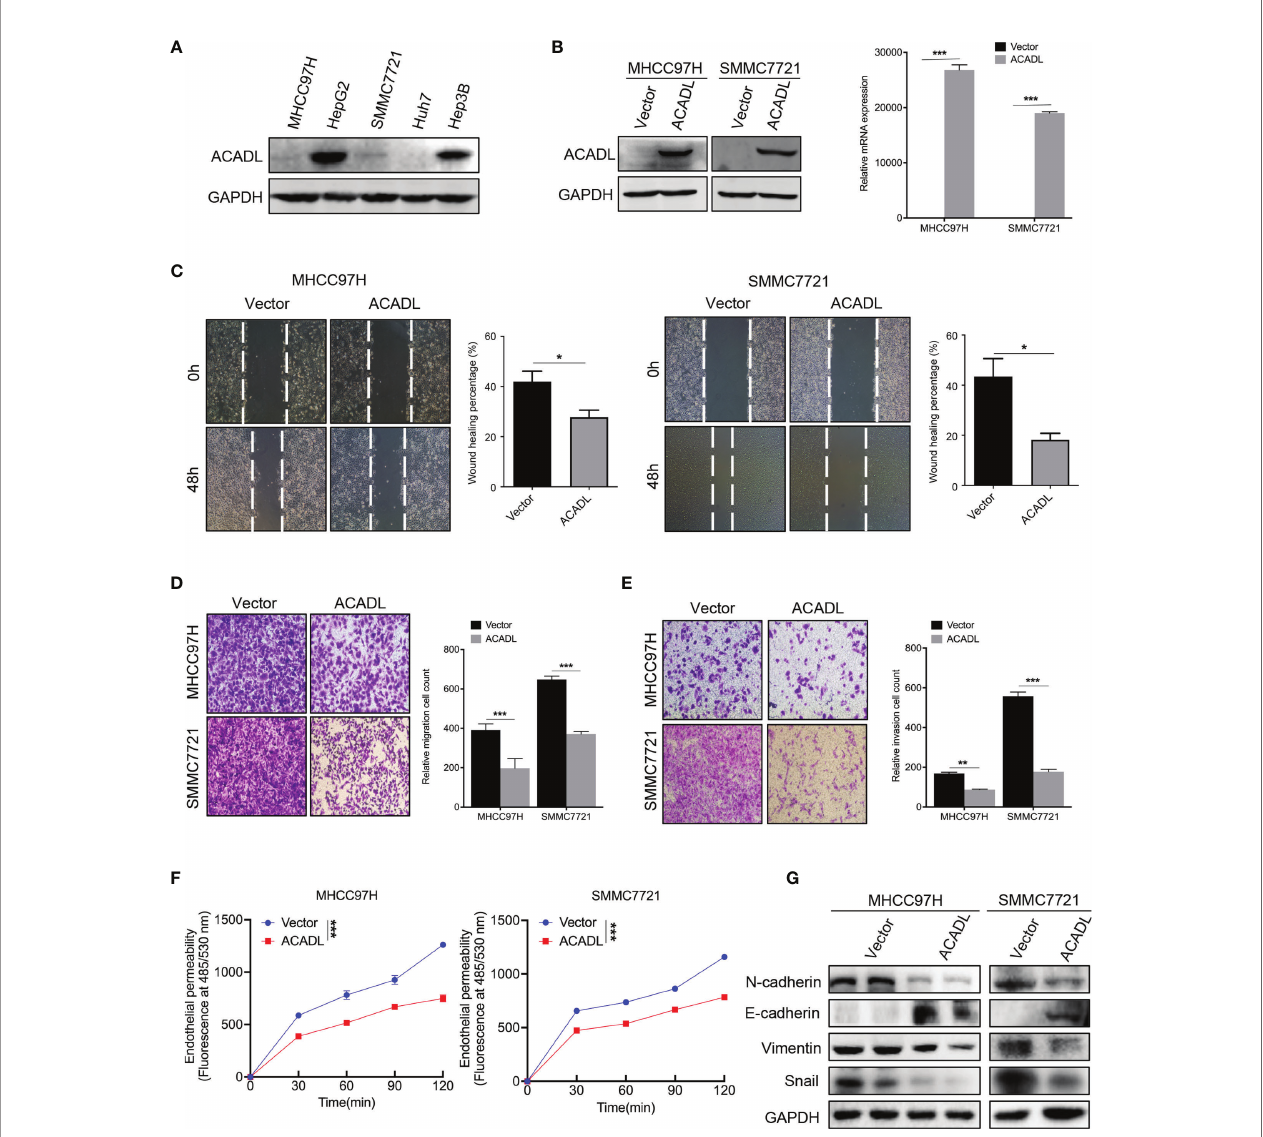
FIGURE 2 | Overexpression of ACADL inhibits HCC cell migration and invasion ability. (A) ACADL protein levels in fi ve different HCC cell lines were determined by WB analysis. (B) ACADL overexpression in MHCC97H and SMMC7721 cells were con fi rmed by WB and qRT-RCR analysis. (C) The wound-healing assay shows the migration abilities of both the cells after the overexpression of ACADL. Original magni fi cation, 100×. (D, E) Transwell shows the migration and invasion abilities of both the cells after the overexpression of ACADL. Original magni fi cation, 200×. (F) Permeability of HUVEC monolayers was analyzed by measuring the fl uorescence of diffused FITC-dextran (70 ~kDa) across the Transwell membrane (mean ± SEM, n = 6, paired t test). (G) WB analysis of EMT markers in ACADL-overexpressing HCC cells. *P < 0.05, **P < 0.01, and ***P < 0.001 compared with the